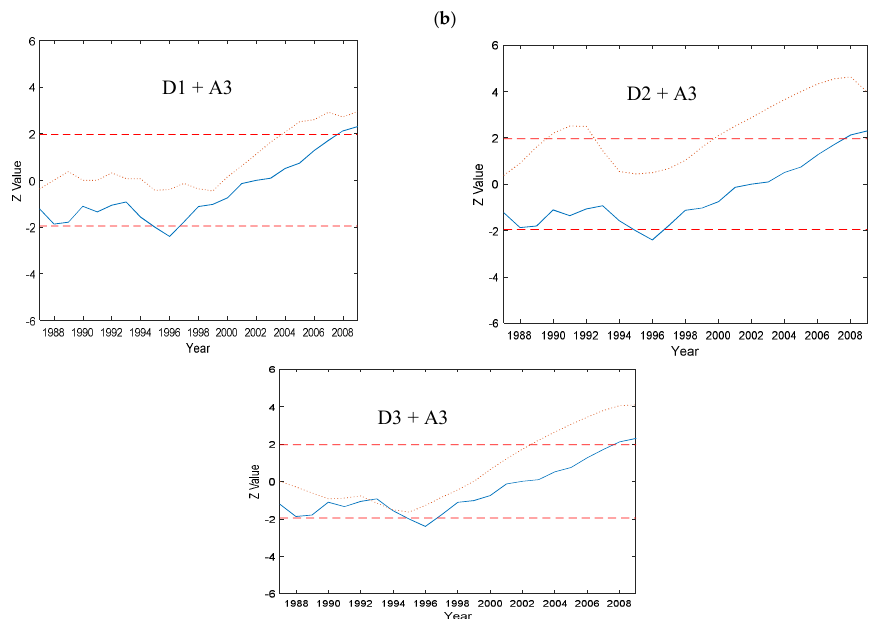
Figure 4. Raisin River: ( a ) Wavelet power spectrum of daily soluble reactive phosphorus (SRP), ( b ) Plots of the sequential Mann–Kendall analyses on the Details (with added Approximation component) of the annual SRP data. The top and bottom dashed lines are ±1.96, which are the confidence limits of the MK test using α = 5%. The solid and dotted lines show the sequential MK values for the original data and the Detail components, respectively. For this SRP data, the D1 (2 years) component was the most dominant periodicity for trend.